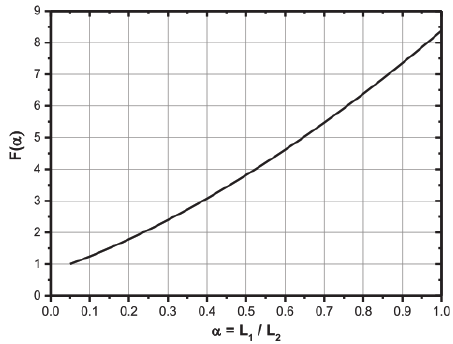
curve with respect to length ratio Figure 3. 𝐹𝐹 ( 𝑎𝑎 )